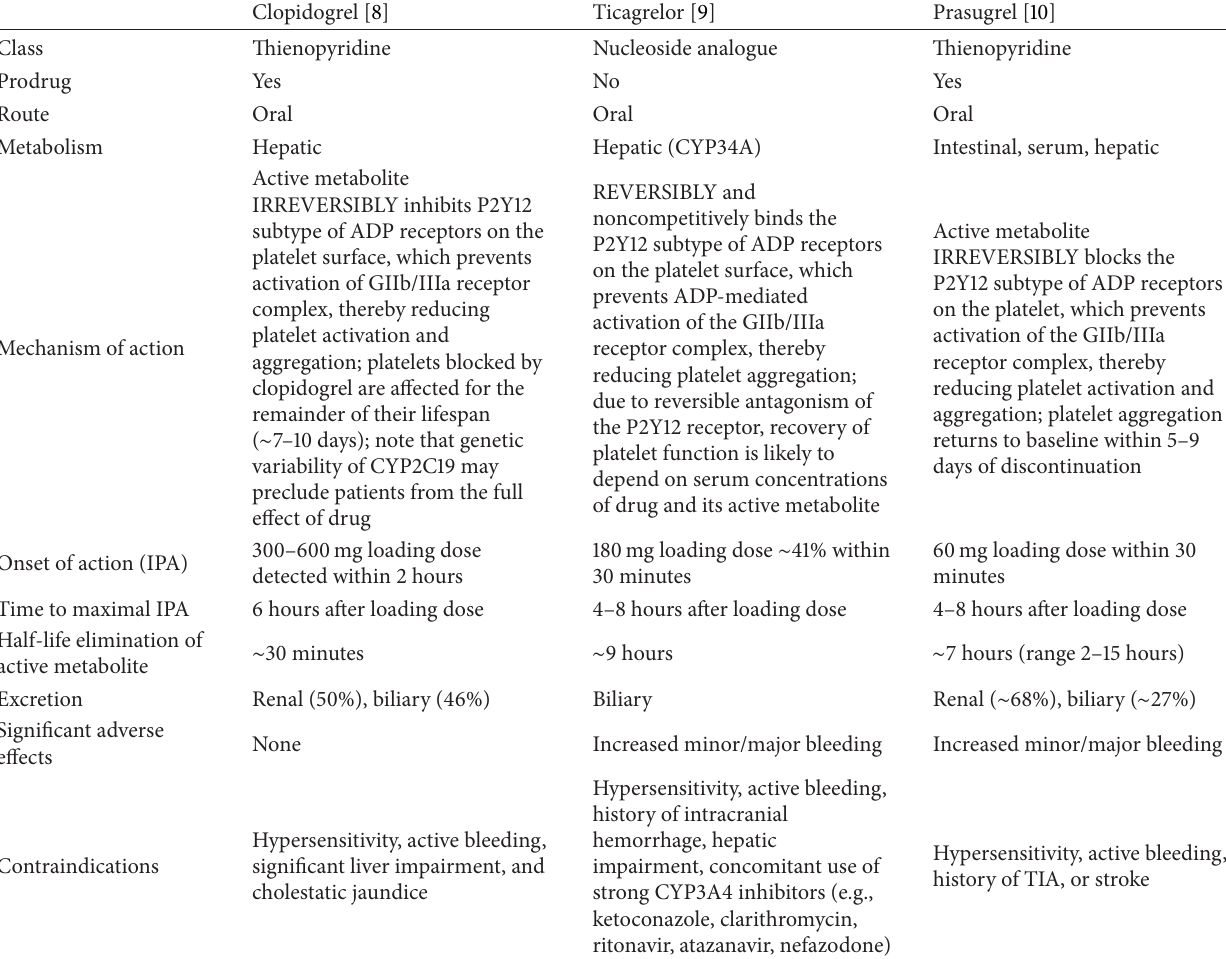
Table 1: Pharmacologic properties of P2Y12 receptor inhibitors used in